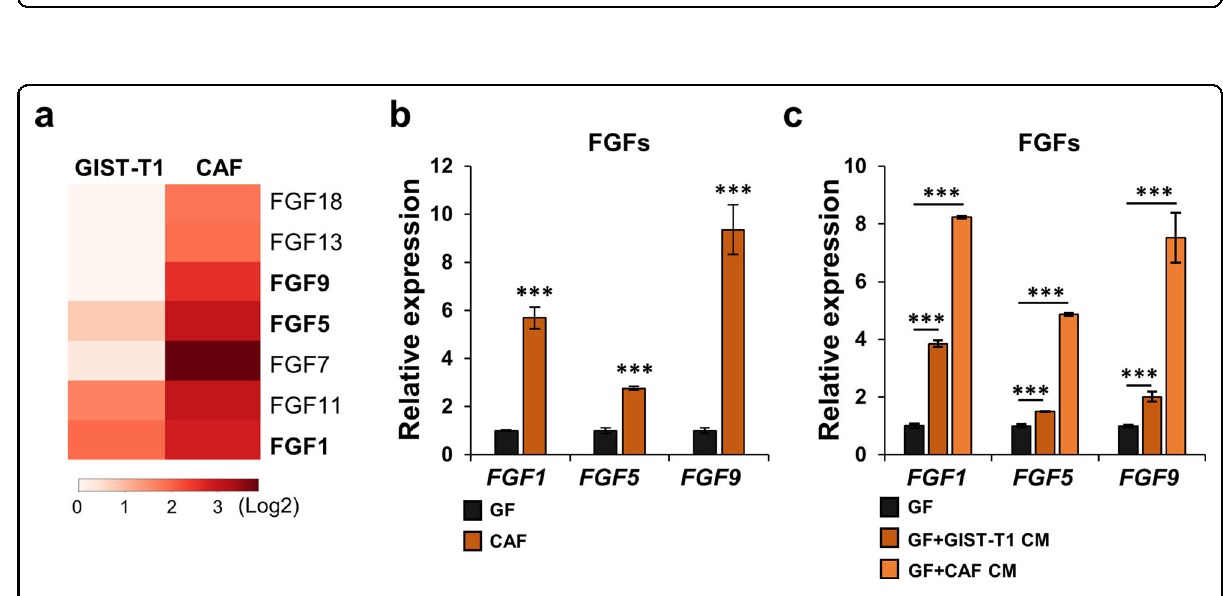
Fig. 2 FGFs are overexpressed in CAFs. a Heatmap of the expression levels of FGF genes in GIST-T1 and CAFs analyzed from RNA-seq (GSE143547). b Expression of FGF1 , FGF5 , and FGF9 in GFs and CAFs by qPCR. c GIST-T1 CM and CAF CM enhanced the expression of FGF1 , FGF5 , and FGF9 in GF. The level of expression was evaluated by qPCR. All graphs show mean ± SEM, and p values were represented by Student ’ s t test or ANOVA analysis. ** p < 0.01, *** p <